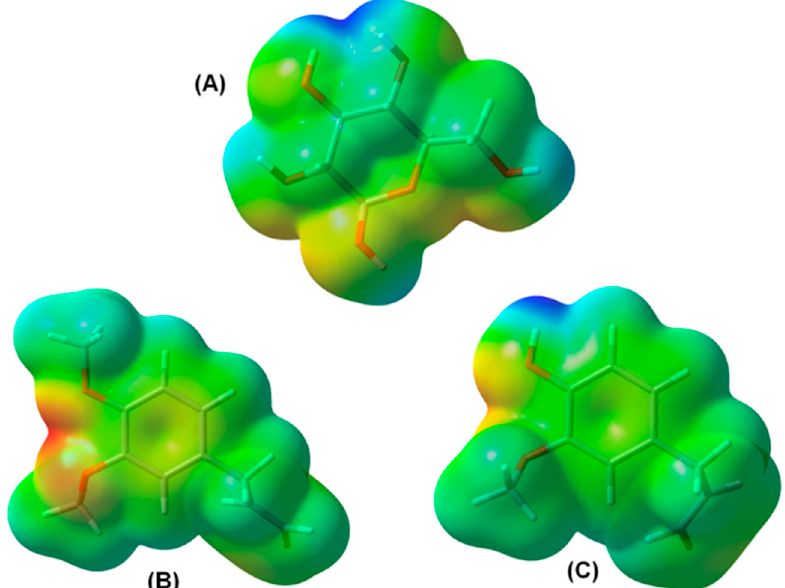
Figure 6. Molecular Electrostatic Potential (MEP) obtained by DFT theory using Gaussian-09 results: glucose ( A ); methyleugenol ( B ); and eugenol ( C